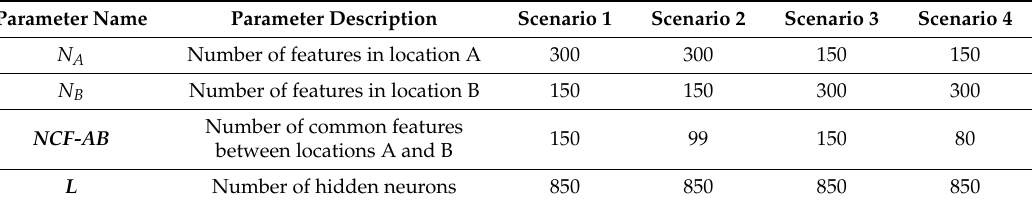
Table 2. Settings of testing scenarios for block size = 300 and regularization parameter C = 2 − 9 for the UJIIndoorLoc dataset.